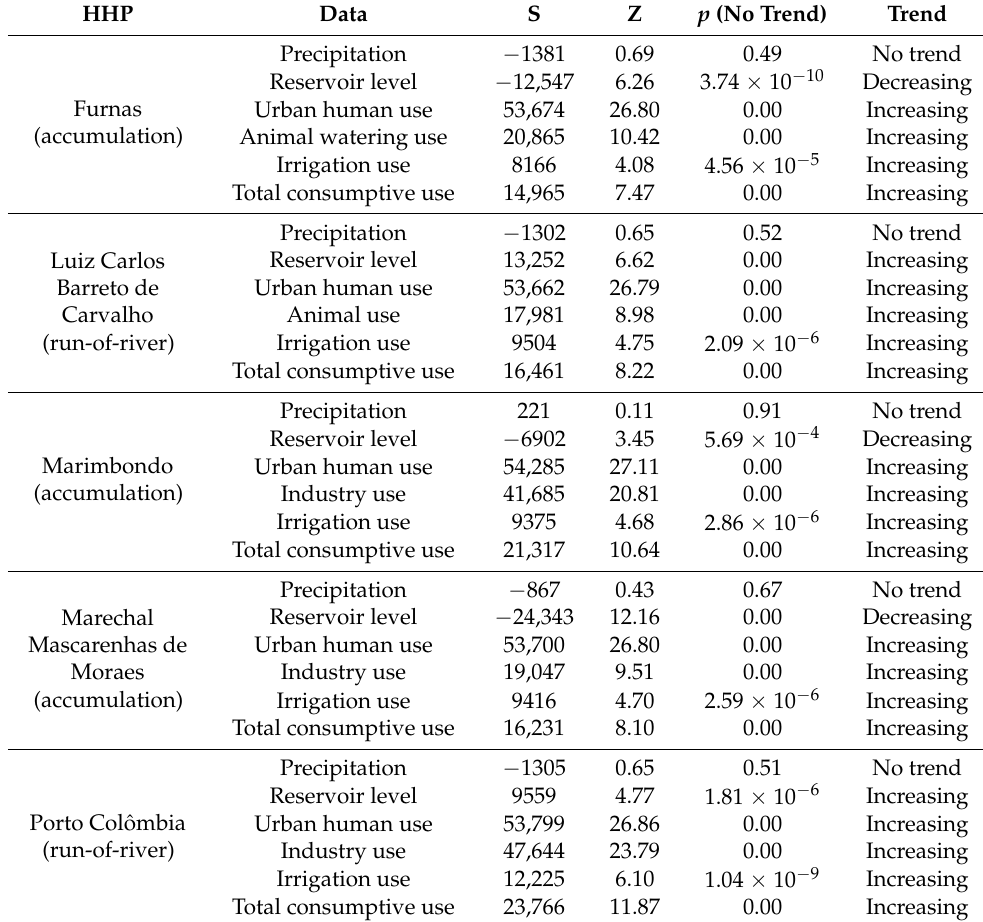
Table 7. Mann–Kendall trend